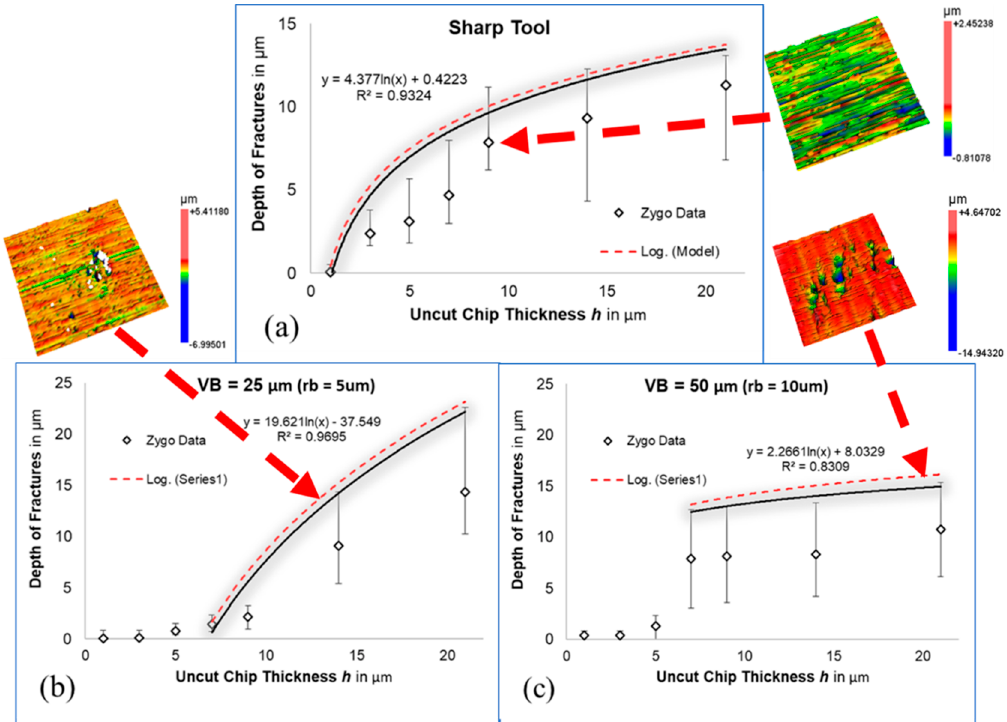
Figure 8. Plot of fracture depth vs. chip thickness for: ( a ) sharp tool, ( b ) worn tool, VB = 25 µm, and ( c ) worn tool, VB = 50 µm.